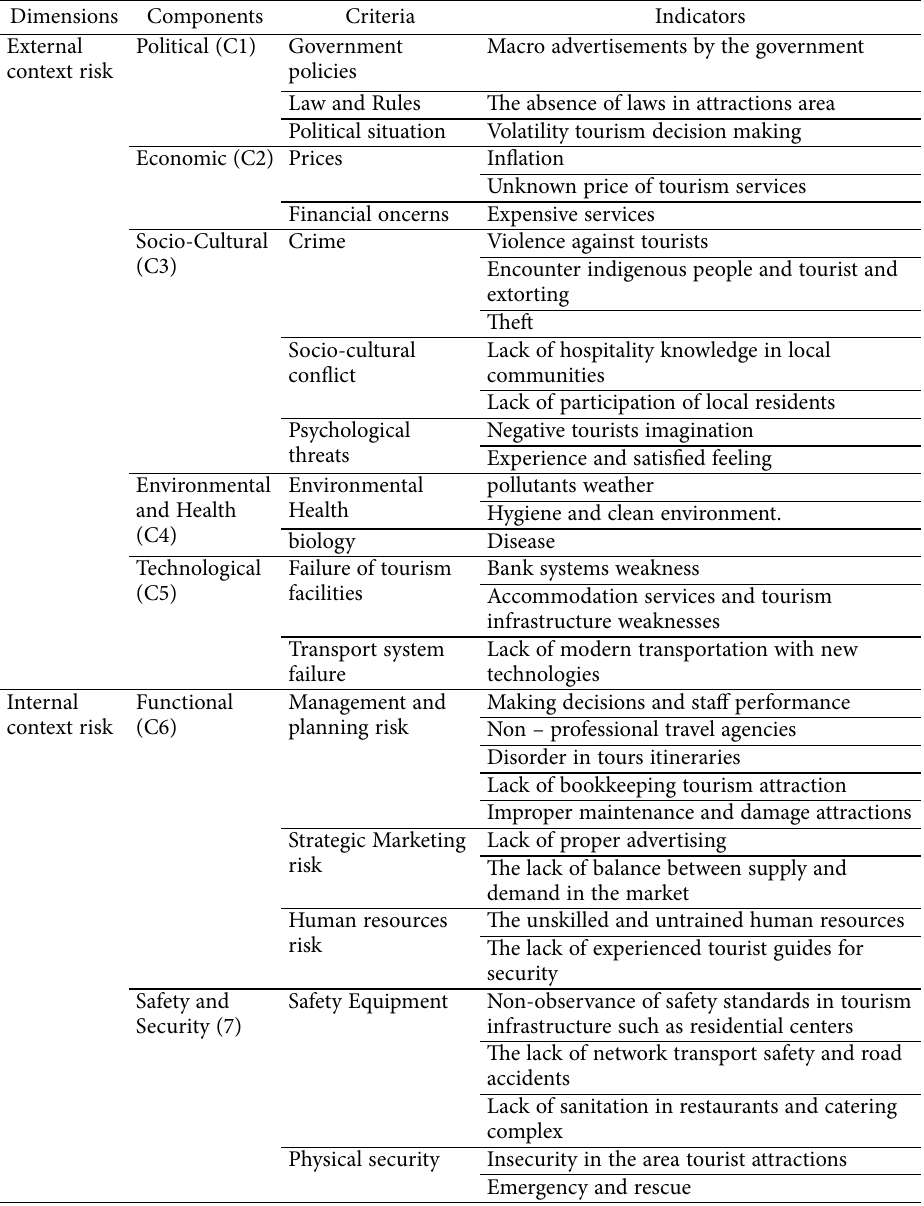
Table 3. Dimensions, components, criteria and indicators for tourism risks